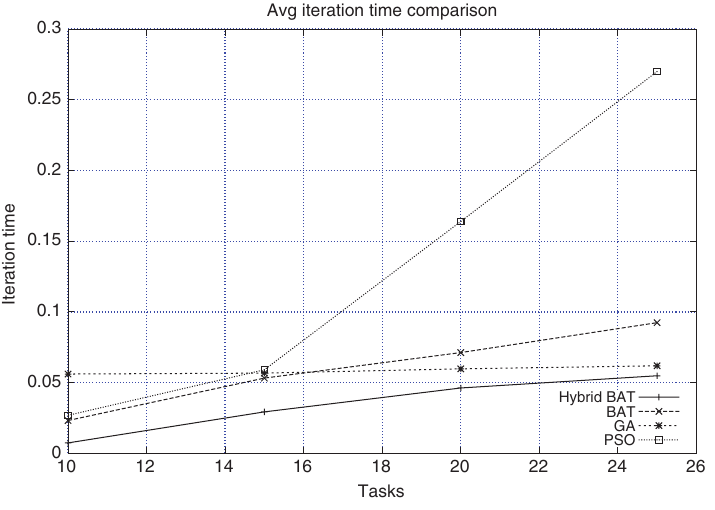
Figure 6: Average iteration